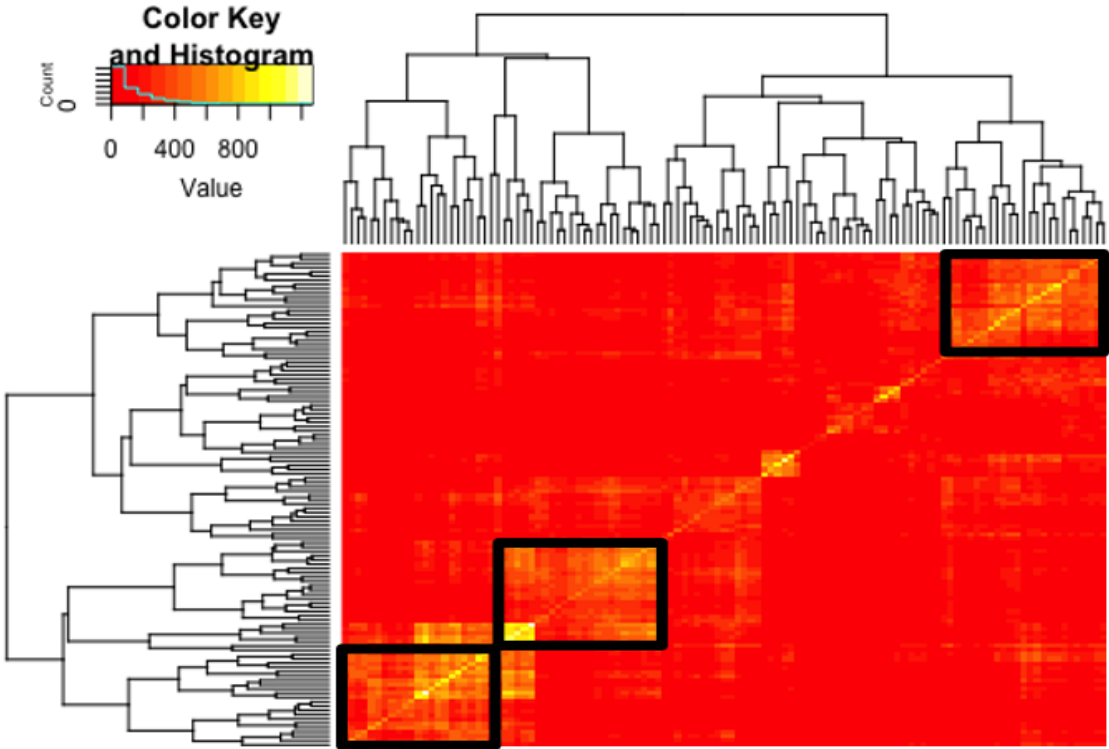
Figure 3. Hypernetwork analysis of day 7 TE interacting endometrial epithelial genes (EEC). Heatmap demonstrating the correlations between EEC genes identified as possessing cognate cell-surface genes in day 7 TE, against the rest of the EEC transcriptome. The same set of genes (n = 115) is present on the columns and rows, thus generating a symmetrical matrix in which the colour scale represents the number of shared correlations between each gene pair. Hierarchical clustering via the dendrogram identified three gene clusters that share highly connected correlations (1, 2 and 3 from bottom left to top right). Red in the heatmap depicts fewer correlations whereas yellow depicts highly correlated genes. The black boxes highlight the most connected clusters.